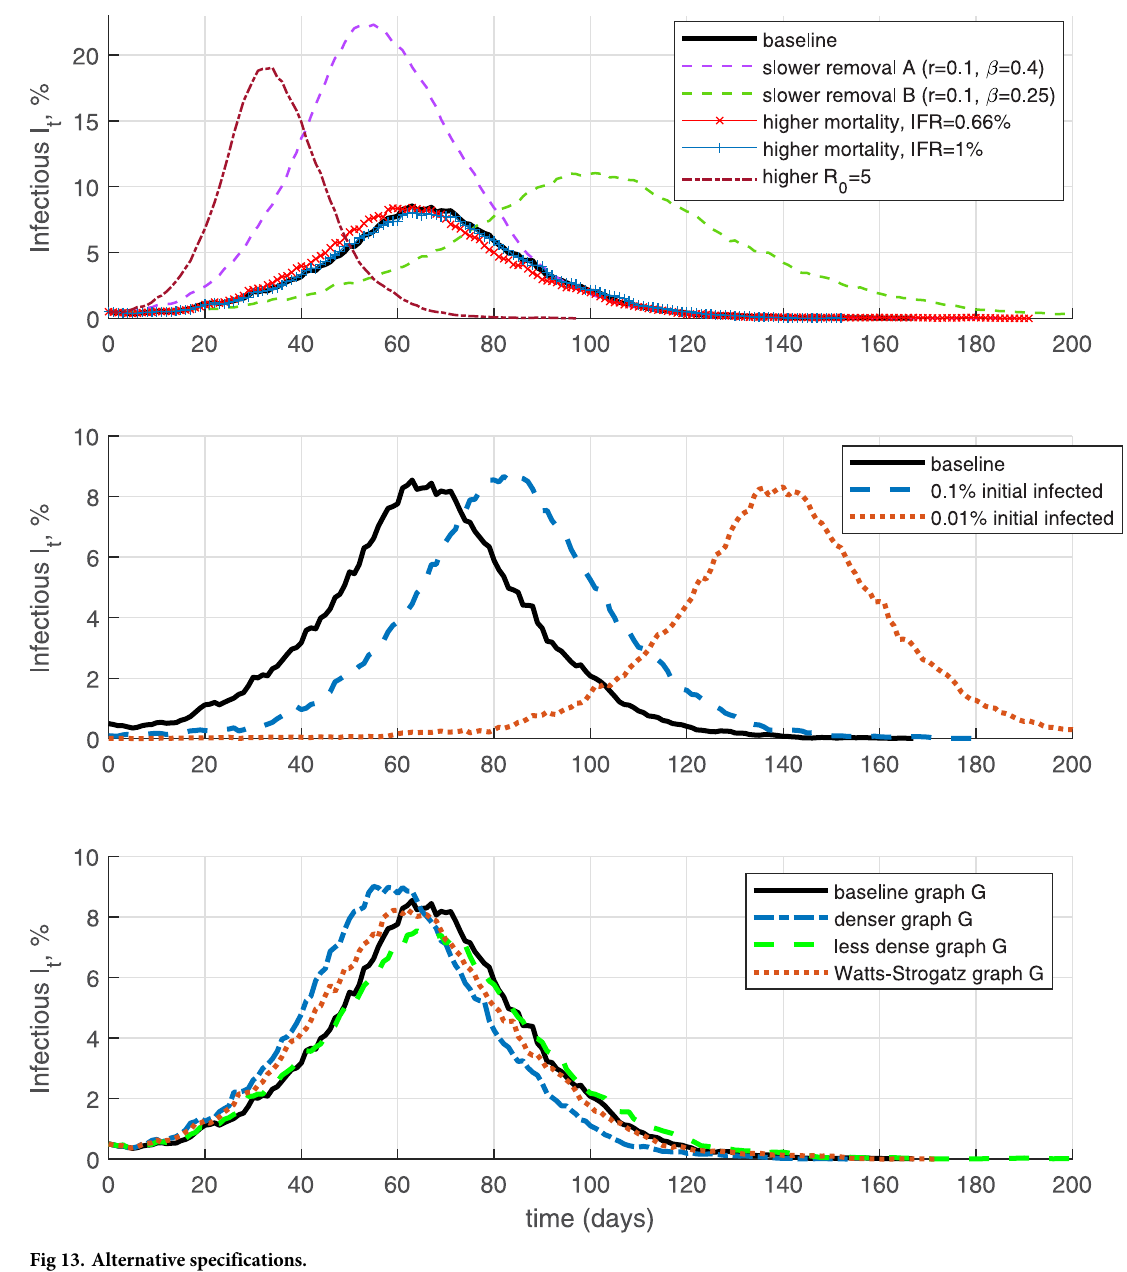
Fig 13. Alternative